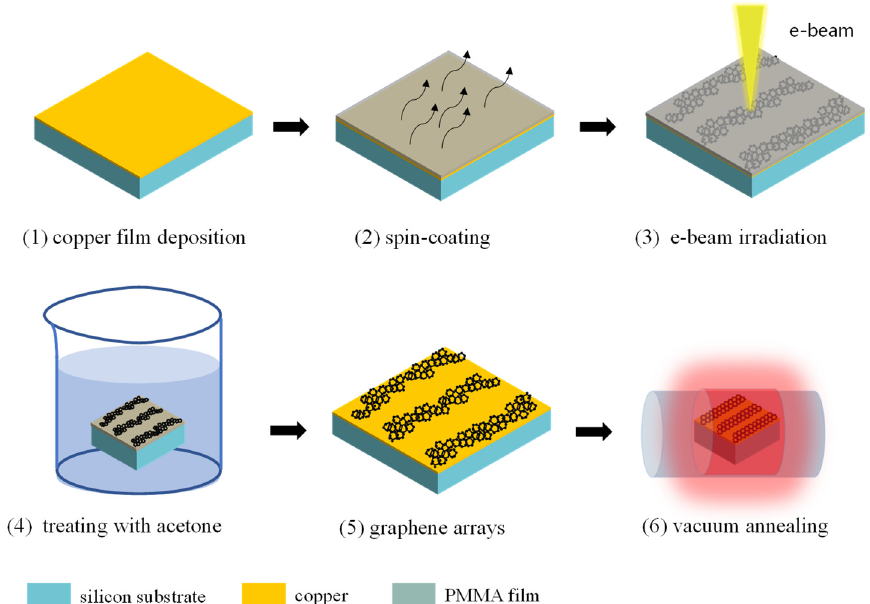
Figure 1. The process flow diagram of the e-beam lithographic process for the fabrication of graphene nanostructures on copper substrate. Low-quality graphene was formed at step 3, and the high-quality graphene at step 6.